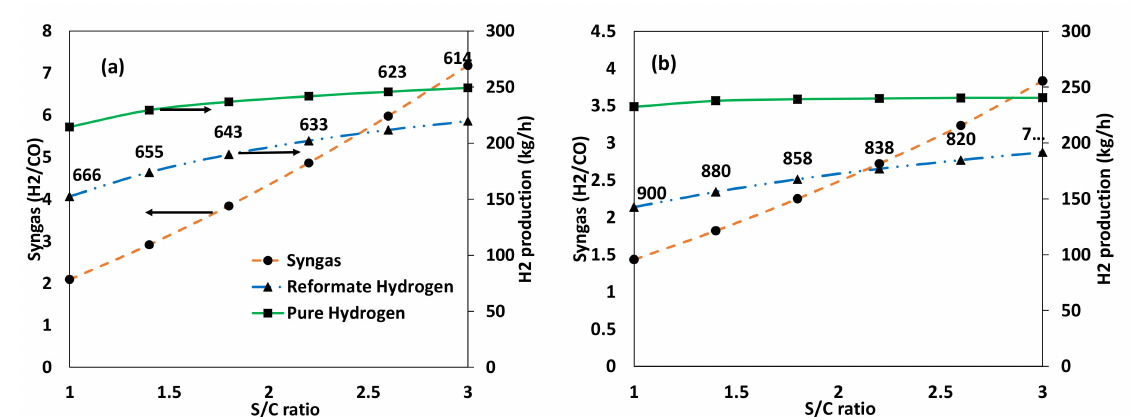
Figure 5. Effect of S/C ratio and equivalence ratio λ on syngas ratio H 2 /CO and hydrogen production. For the base case, ATR occur at 3 bar ( a ) λ = 0.23; ( b ) λ = 0.36. Equilibrium temperatures in Celsius degrees ( ◦ C) are included as data